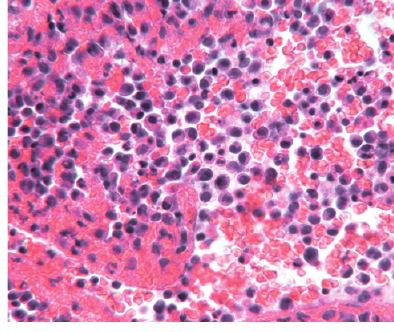
Figure 3. Cytological analysis of the pleural fluid showed plasma cells consistent with